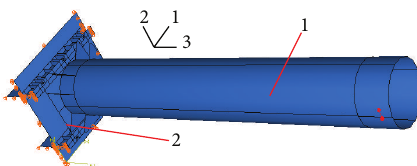
Figure 8: The von Mises stress (Pa) distribution in the slab at level 0.00 m.